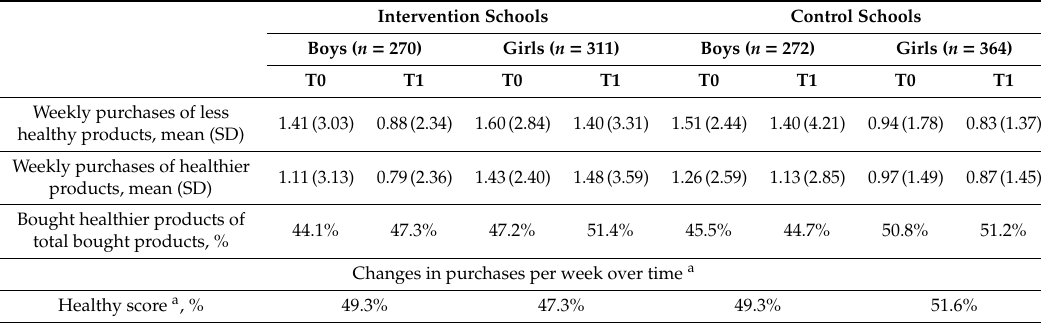
Table 4. Weekly food and drink purchases at the vending